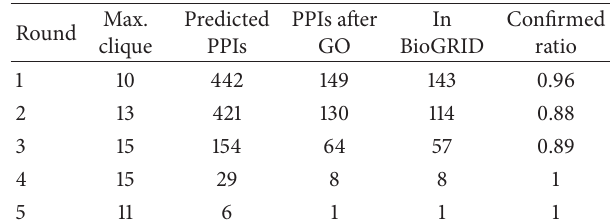
Table 1: Prediction steps of CORE validated with BioGRID.